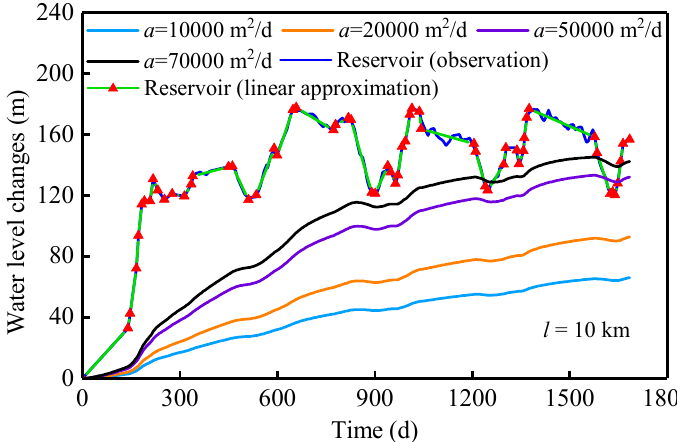
Figure 6. Approximation of the Xiluodu reservoir level variations by piecewise linear segments and the average increment of the hydraulic head of the confined aquifer.